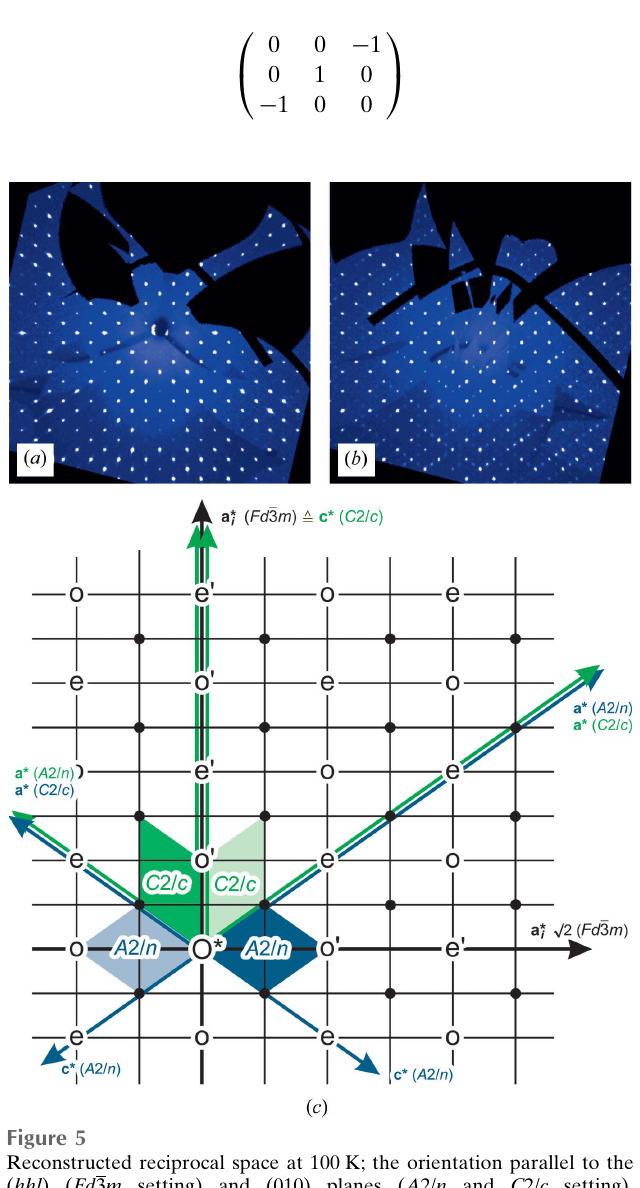
Figure 5 Reconstructed reciprocal space at 100 K; the orientation parallel to the ( hhl ) ( Fd 3 m setting) and (010) planes ( A 2/ n and C 2/ c setting), respectively. ( a ) Section centered in 000 (= O*). ( b ) Section centered in 220. ( c ) Axes directions are indicated in a corresponding schematic drawing of the reciprocal lattice. The cubic basis vectors ( Fd 3 m ) are represented by black arrows, and the reduced monoclinic A 2/ n and the standard monoclinic C 2/ c settings are given in blue and green, respectively. Twin domains following the twin law for the A 2/ n setting (0 0 (cid:4) 1 / 0 1 0 / (cid:4) 1 0 0) are shaded. Reciprocal-lattice points corresponding to weak superstructure reflections are marked by small black dots. o and e mark strong reflections occurring in odd planes only or even planes only, respectively; e 0 and o 0 mark reflections missing in the equatorial plane for space group Fd 3 m according to the reflection conditions of the d -glide plane ( k + l = 4 n for 0 kl